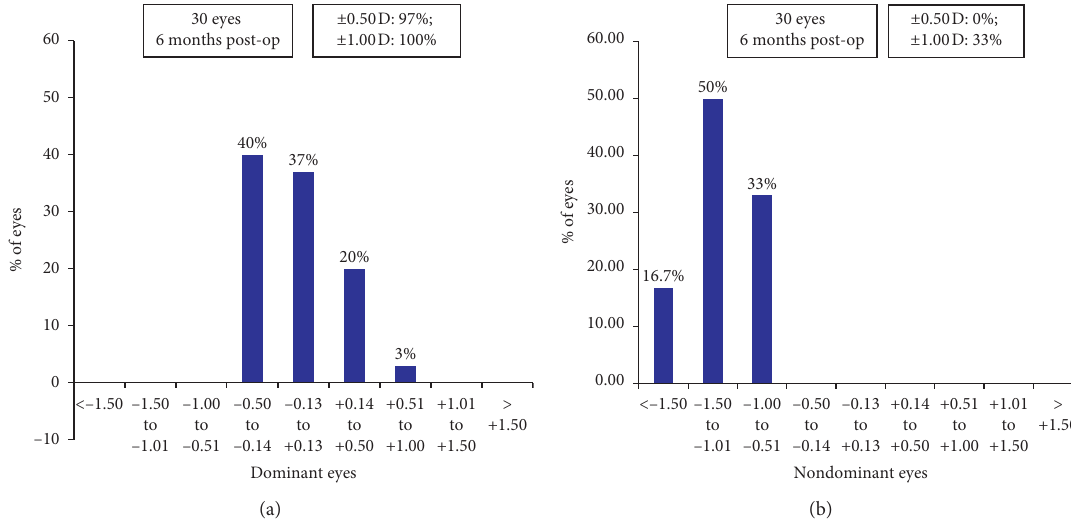
Figure 3: Histogram showing the accuracy to the intended spherical equivalent refraction for (a) dominant and (b) nondominant eyes at 6 months post-op.